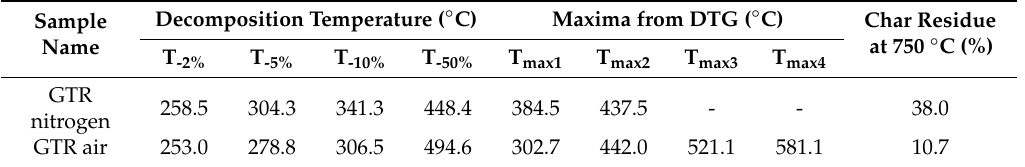
Figure 3. TGA and DTG curves for GTR in nitrogen and in air atmosphere. Table 3. Thermal decomposition characteristics of GTR in an inert (nitrogen) and in air atmosphere.